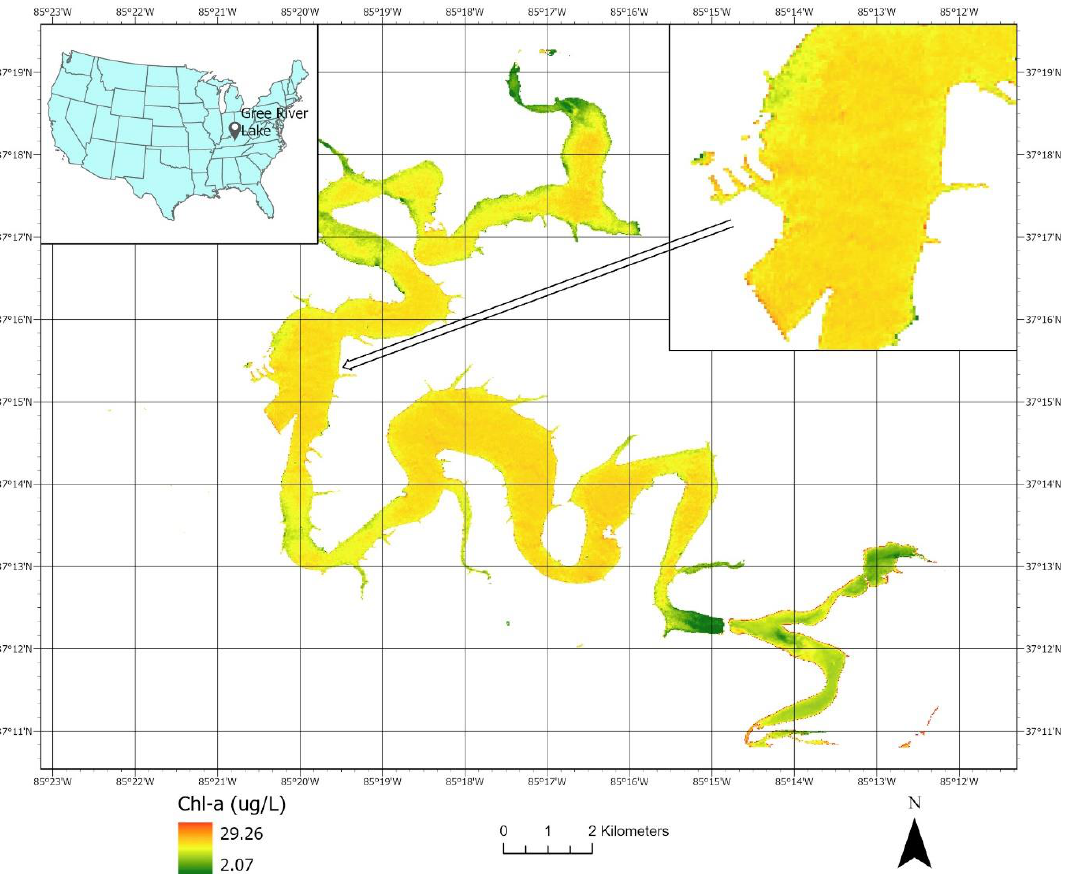
Figure 5. Predicted Chl- a concentration of the Green River Lake, Kentucky with a Sentinel-2 (Scene ID: L1C_T16SFG_A009904_20170515T163103) overpass on 28 August 2016.